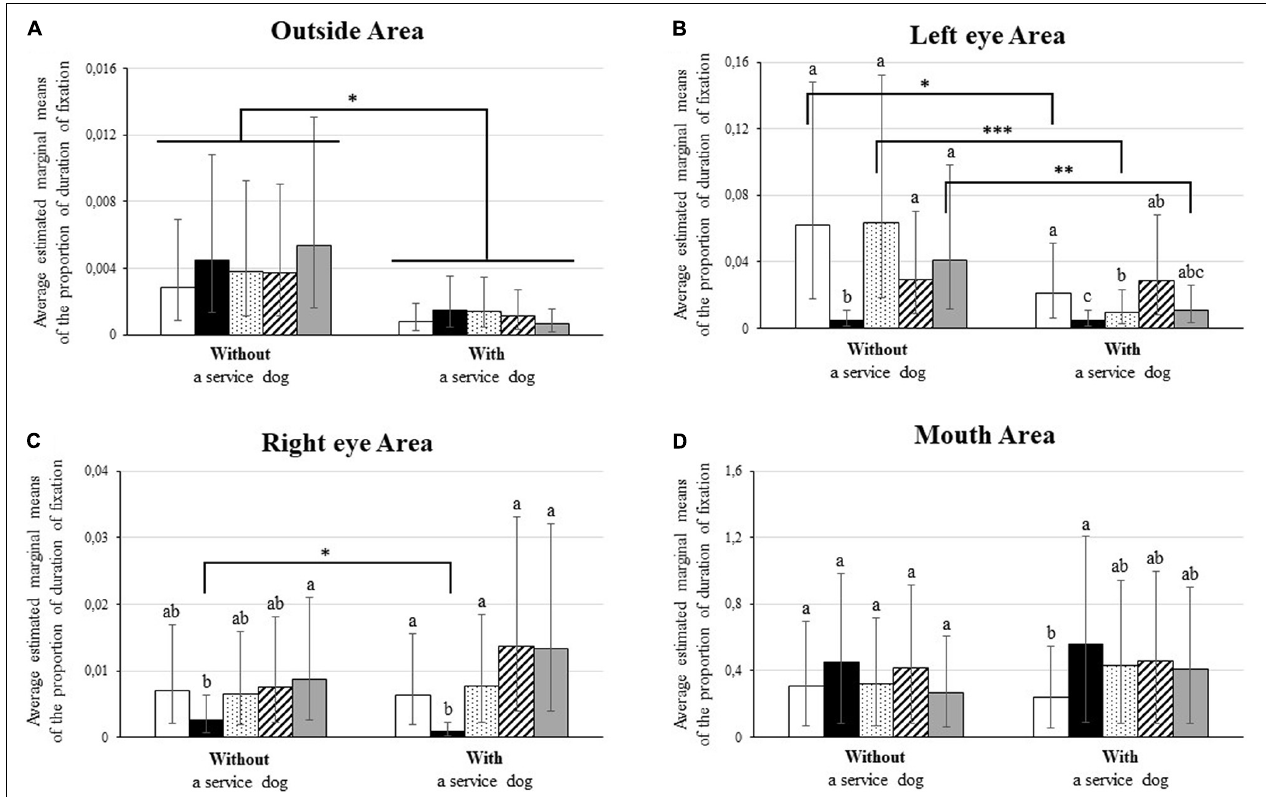
FIGURE 2 | Mean proportion of fixation of children with ASD according to children’s group and to the displayed facial expression for: (A) the outside area, (B) the left eye area, (C) the right eye area, and (D) the mouth area. Facial expressions are represented in color code: anger in white, joy in black, neutral in dotted pattern, fear in striped pattern, and sadness in gray. Lower case-letters and stars refer significant differences. Lower-case letters refer significant results from comparisons between expressions within in each group. Data (i.e., facial expressions) referring different letters within the graph differed significantly at p ≤ 0.05, while data that share a common letter did not. Stars refer to results from comparisons between groups within each facial expression. ∗ p ≤ 0.05, ∗∗ p ≤ 0.01, ∗∗∗ p ≤